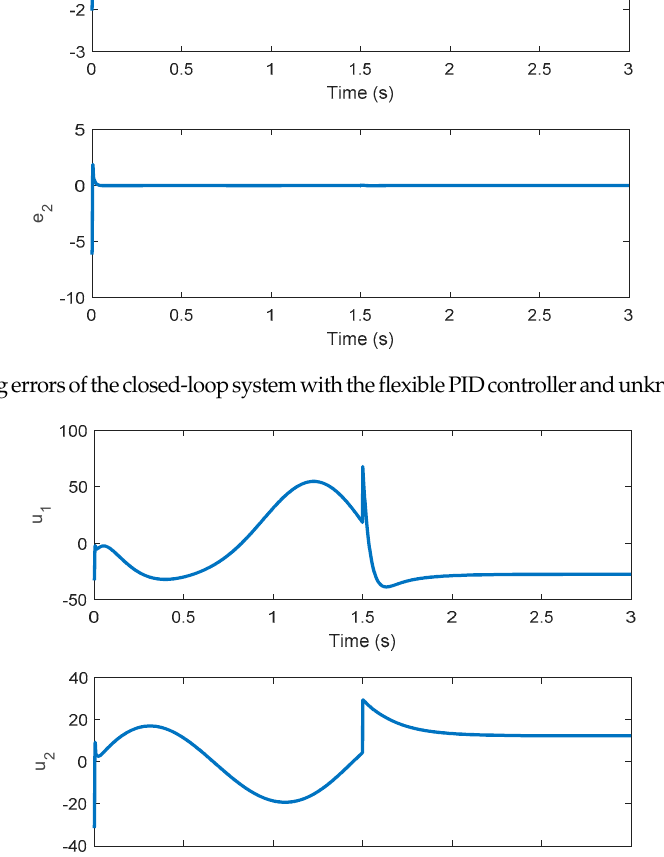
Figure 9. Control inputs based on the flexible PID controller and unknown perturbation.